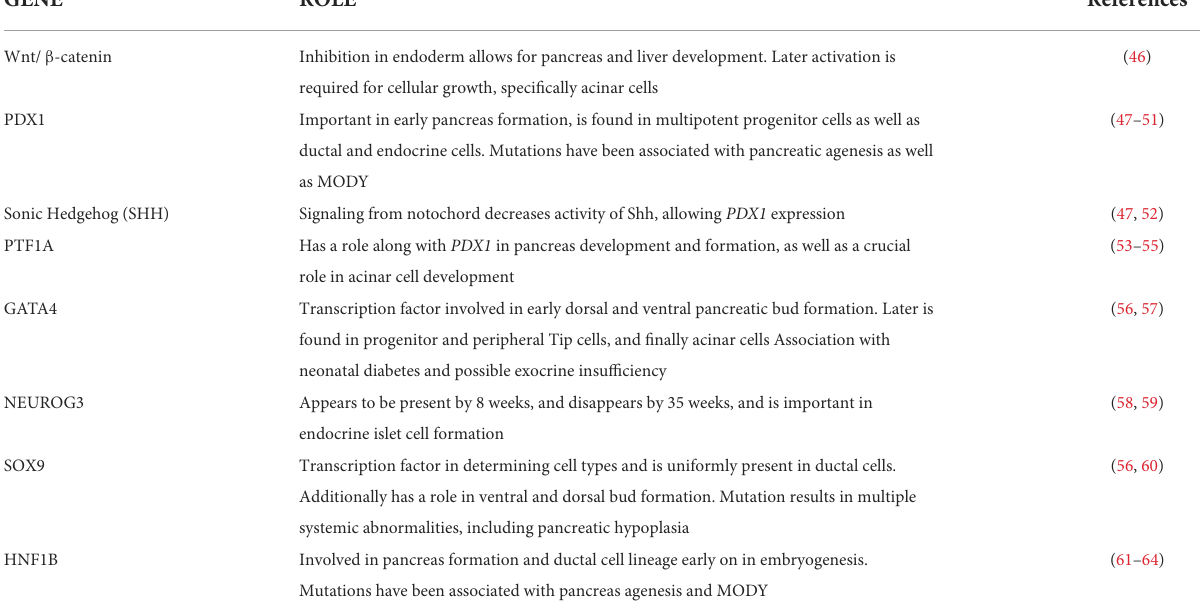
TABLE 2 Transcription factors and cell signaling involved in human pancreas